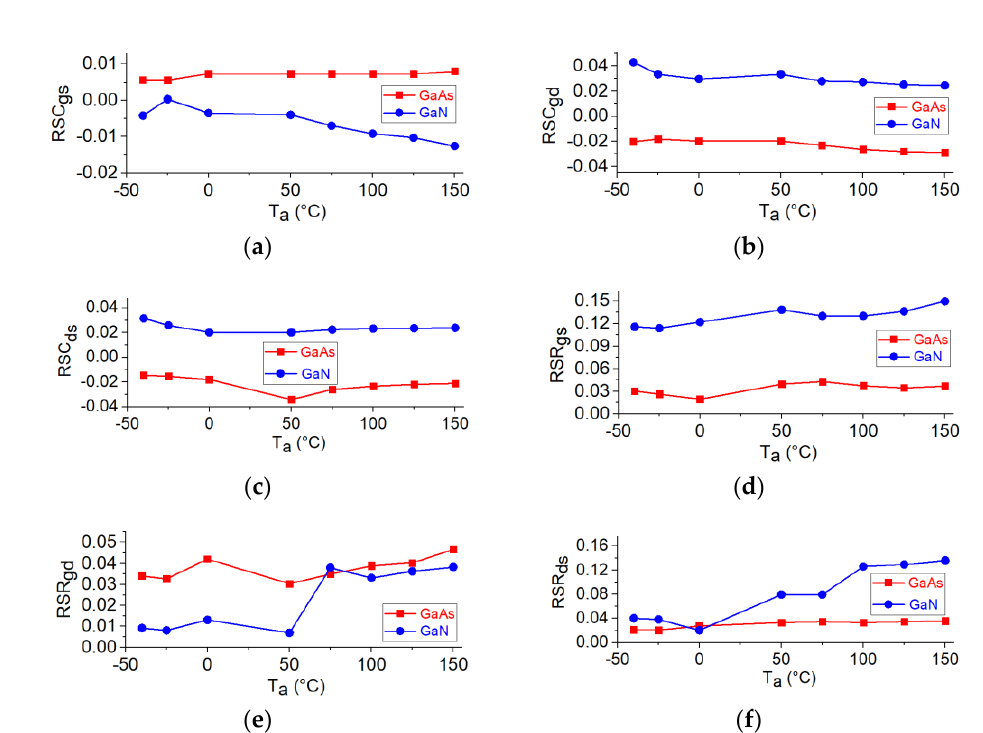
Figure 9. Behavior of the relative sensitivities of the extrinsic parameters versus T a for the two studied devices.